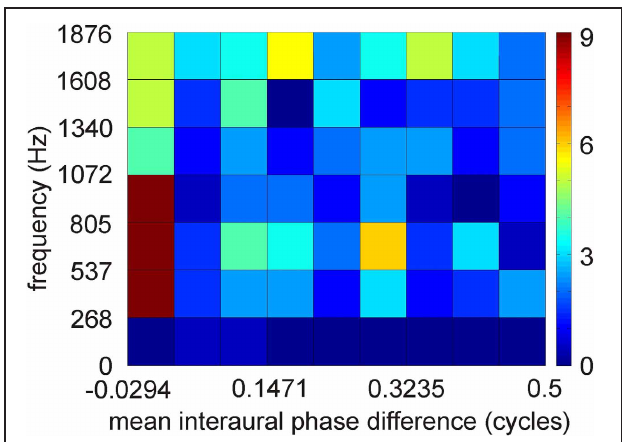
FIGURE 4 | Distribution of interaural phase difference in low-best frequency neurons of ICCc. Distribution of 251 data points. Interaural phase differences were calculated from interaural time differences by first restricting the mean interaural phase differences to a range from − 0.5 to 0.5 cycles by phase wrapping and then take the absolute value. A binwidth of 0.0625 and of 268Hz was chosen to make the data comparable to the model data of Harper and McAlpine (2004).